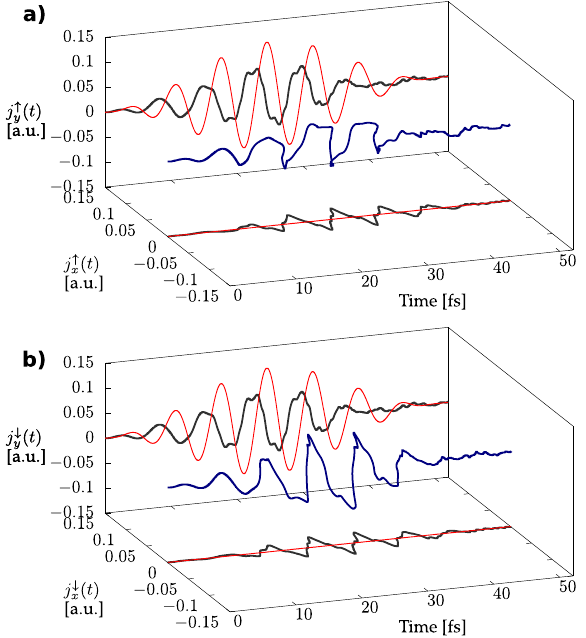
Fig. 6 Spin-resolved electron dynamics in presence of SOC. Calculated electronic current (blue) for the ( a ) up spin channel, and ( b ) down spin channel for a linearly-polarized laser fi eld along the y axis. The projections of the current on the x and y axis are shown in black. The time pro fi le of the vector potential is shown in